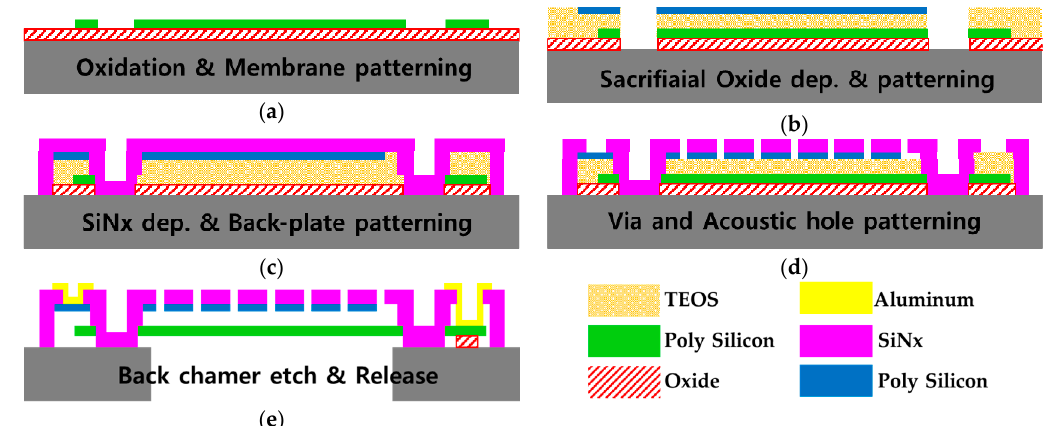
Figure 3. Fabrication process of the MEMS microphone with dual anchored membrane.